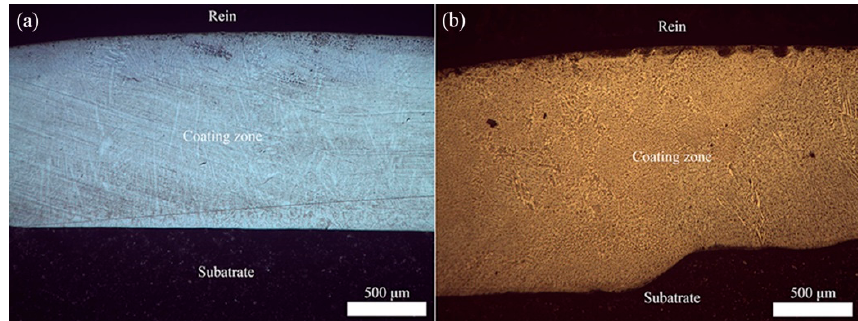
Figure 3. Cross-section morphologies of ( a ) Coating 1 and ( b ) Coating 2.